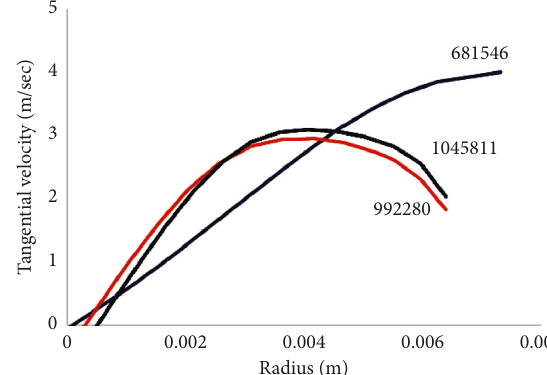
Figure 4: Calculation of tangential velocity versus radiuses if the hydrocyclone with different calculation